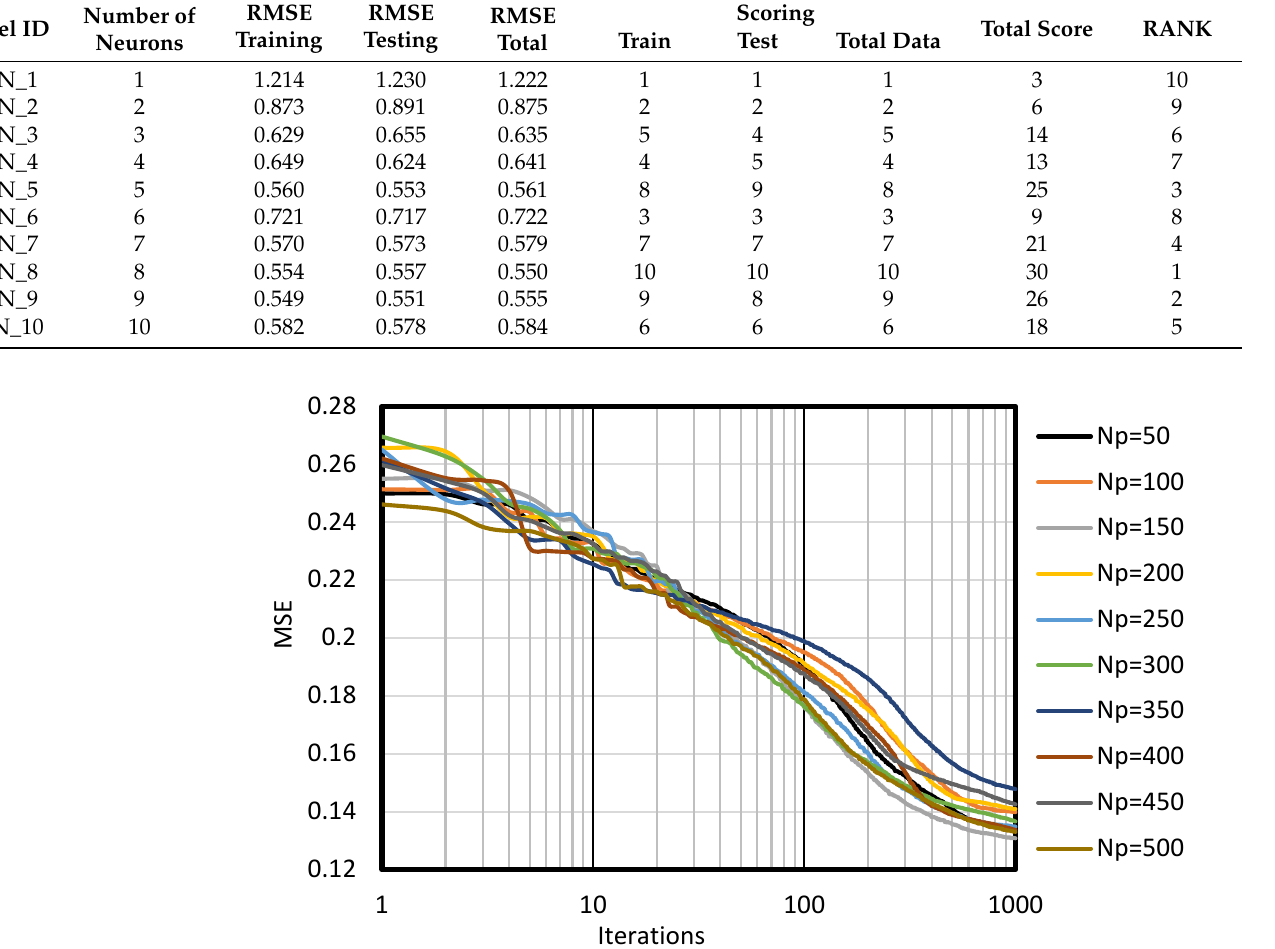
Figure 7. The variation of mean squared error versus iterations obtained from the proposed BBOMLP structures in predicting landslide susceptibility mapping.